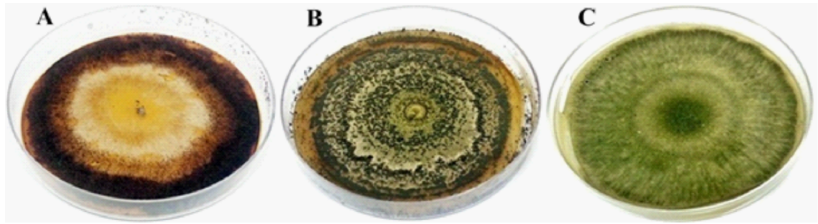
Figure 1. Fungal isolates. ( A ): Escovopsis sp.; ( B ): Metarhizium anisopliae ; ( C ): Trichoderma strigosellum